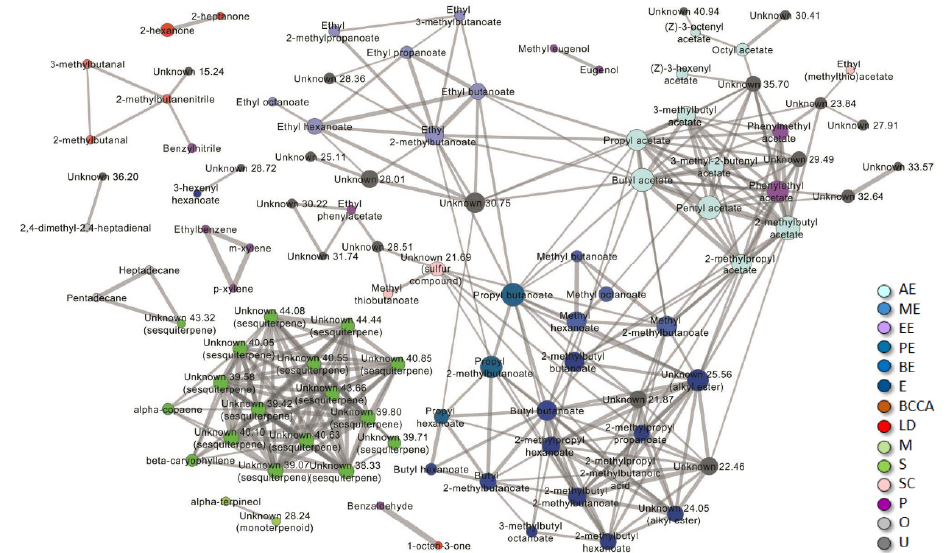
Figure 2. Correlation network analysis of the rind VOC data set. The nodes representing volatiles are colored according to the volatile chemical group as indicated in the image. Correlations over 0.85 are indicated. Line thickness indicates correlation strength: the wider the line, the stronger the correlation.